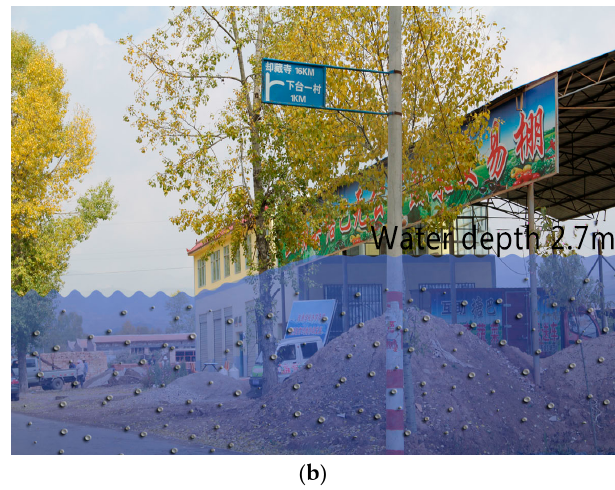
Figure 21. Digital inundation photos for two key downstream sites: ( a ) Gelong Village; and ( b ) Xiatai Village.